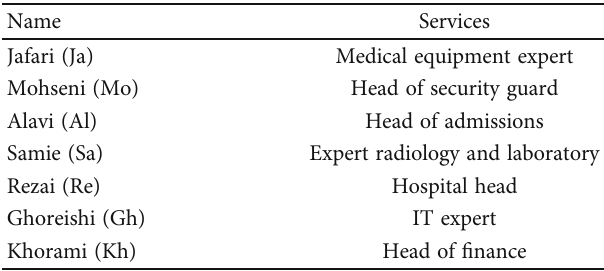
Figure 10: G is NEI and NETI-IVIFG but it is not SEI and SETI-IVIFG. Table 2: The names of the sta ff and their specialization in the hospital.